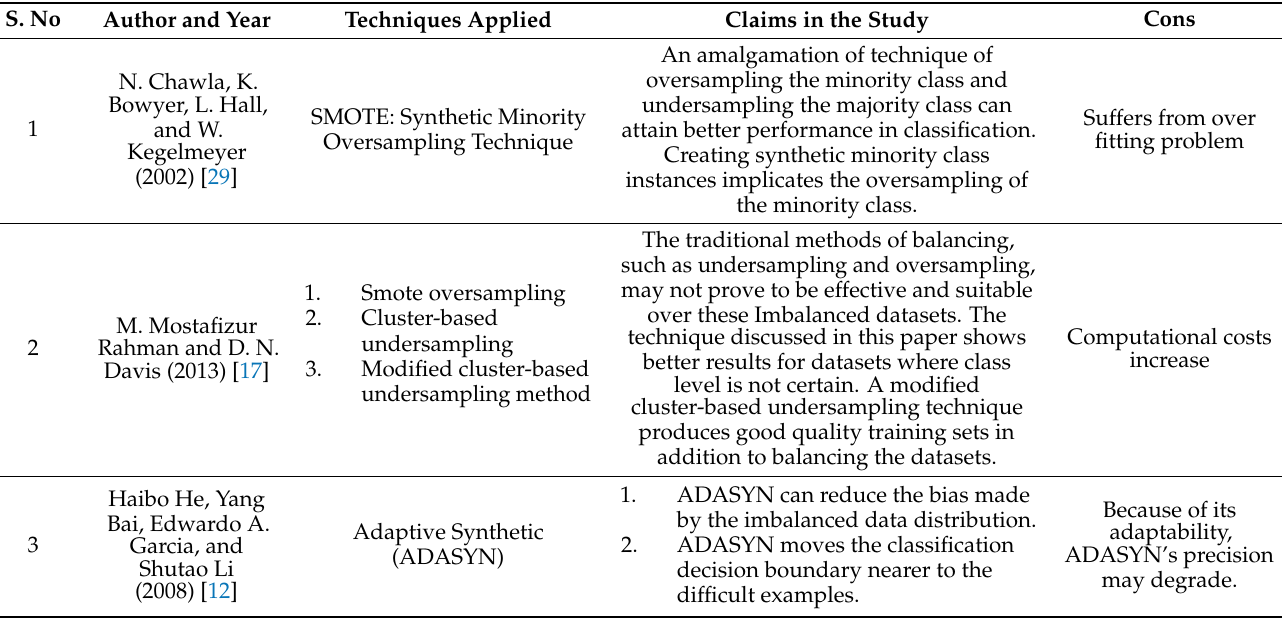
Table 3. Summarized related works from literature for balancing